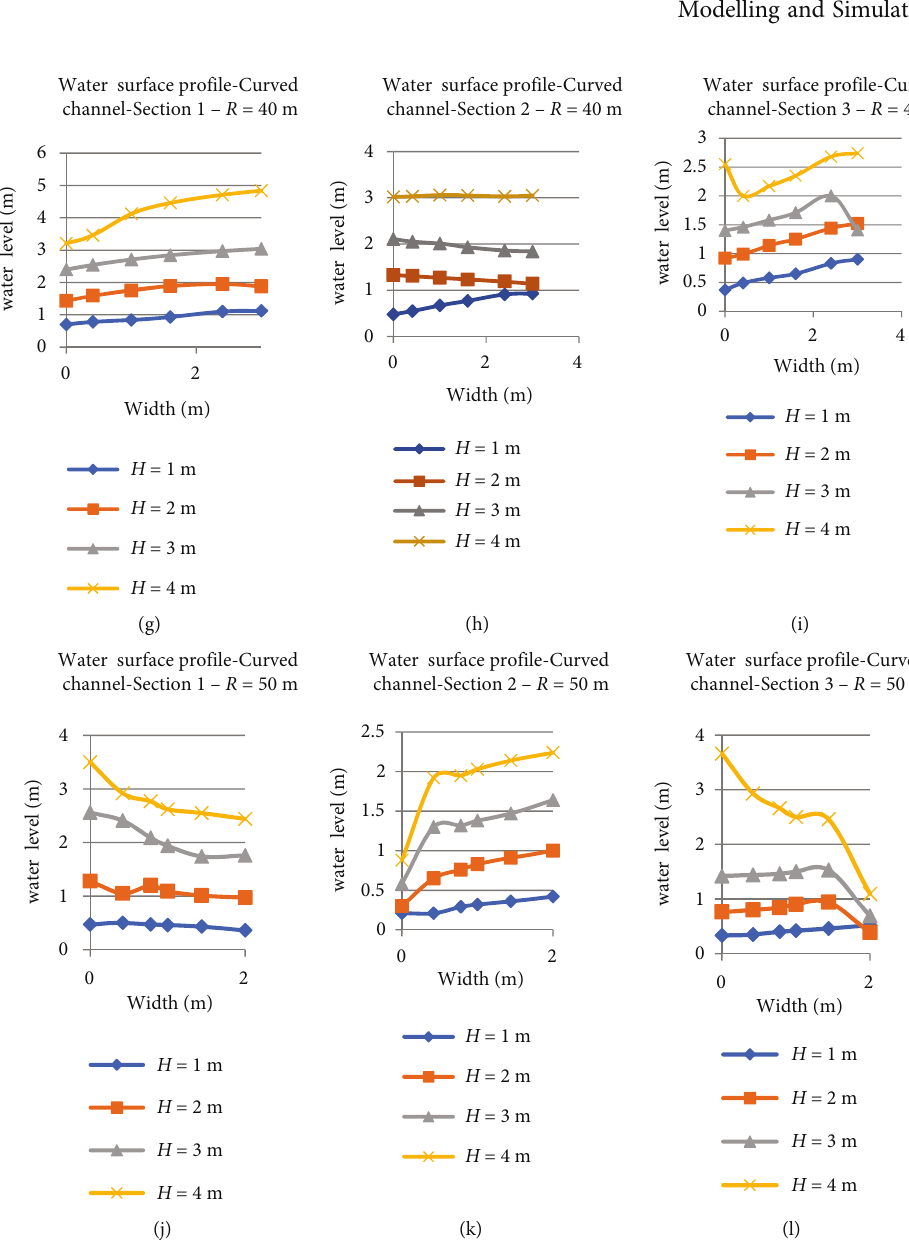
Figure 5: Cross-section water level for the tested